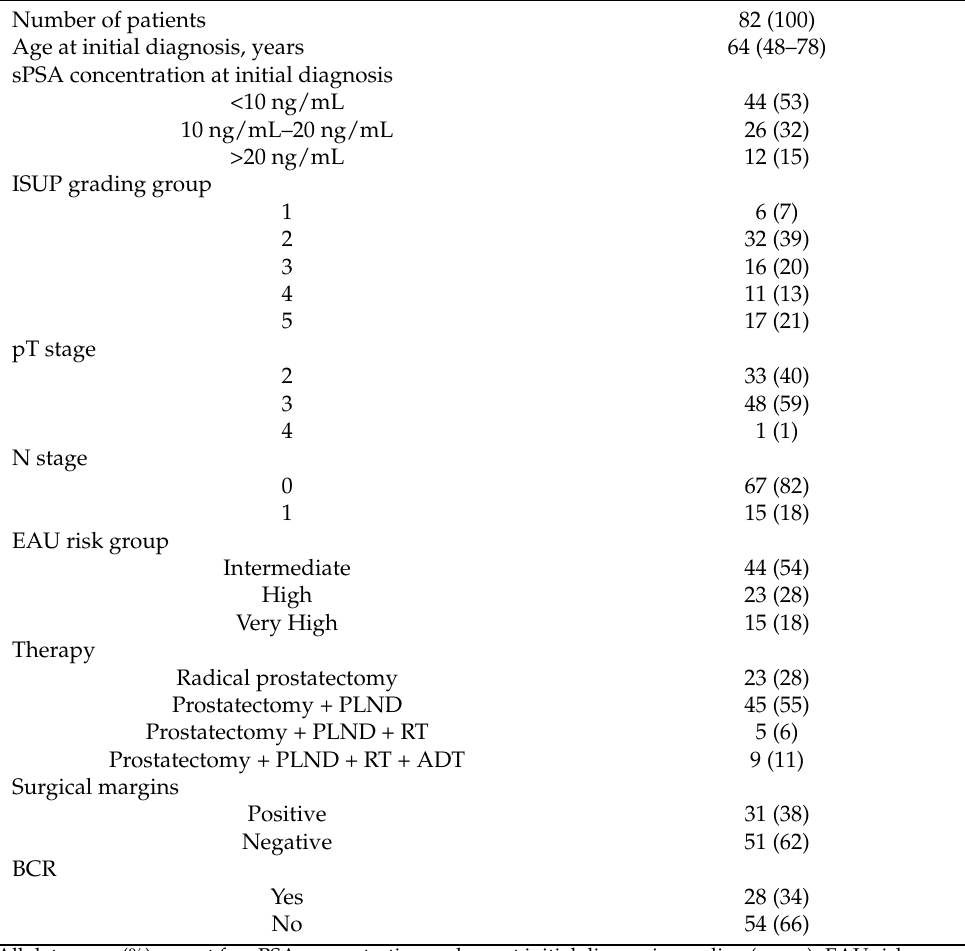
Table 1. Patient